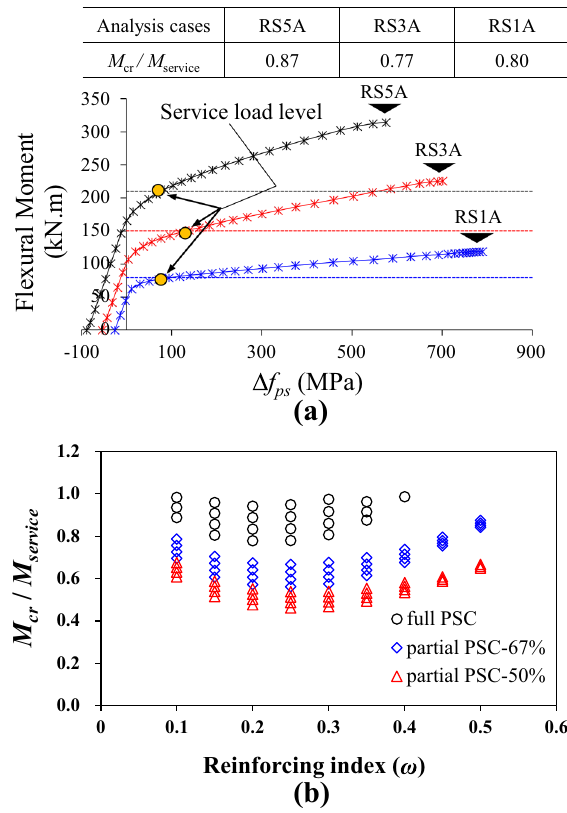
Fig. 7 Effect of reinforcing index on D f ps . a Effect of reinforc- ing index on D f ps of selected sections and b Effect of reinforcing index and PPR on M cr / M